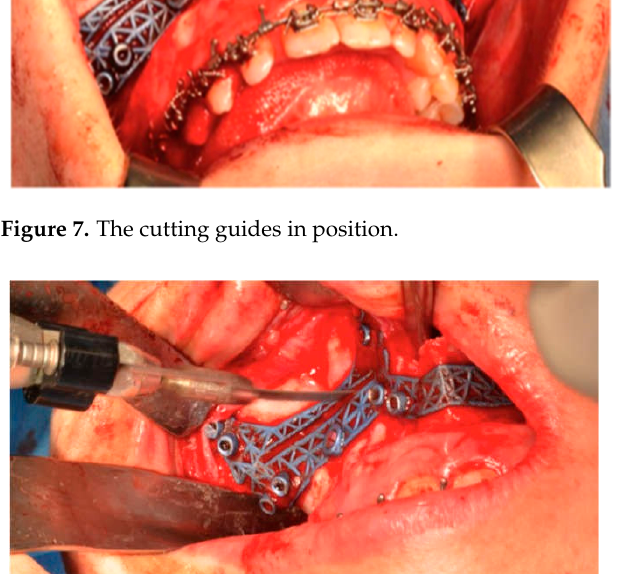
Figure 7. The cutting guides in position.